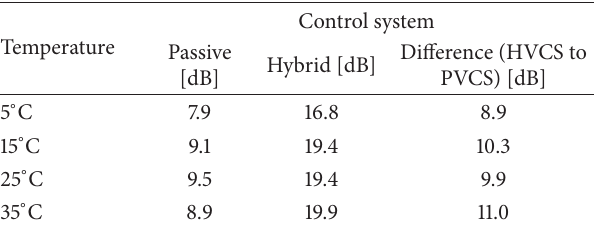
Table 4: PVCS and HVCS performance (vibration attenuation related to the uncontrolled beam vibration levels), broadband analysis.